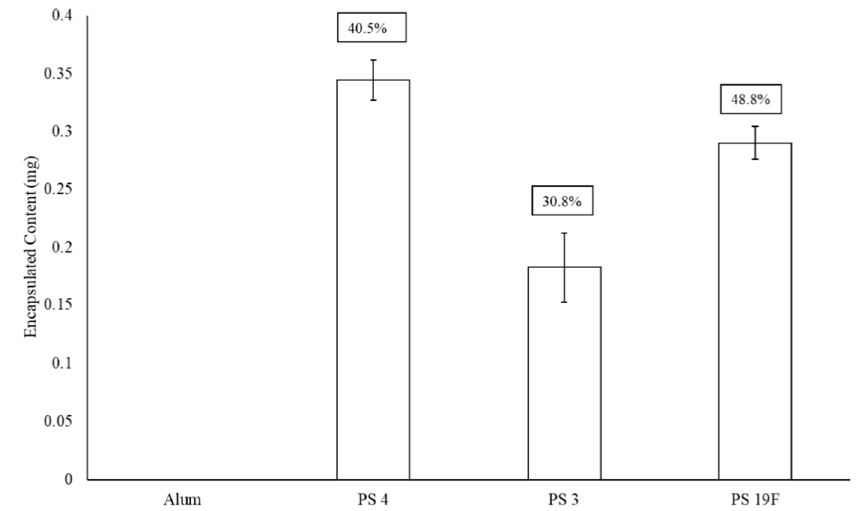
Figure 4. Effect of adjuvant (alum) on LEPS polysaccharide (PS) encapsulation efficiency (boxed values, with comparison to best values for PS 4 and 3 in Figures 2 and 3; with GFP surface protein addition). Alum was tested with a liposomal sample without PS to confirm lack of background signal interference.